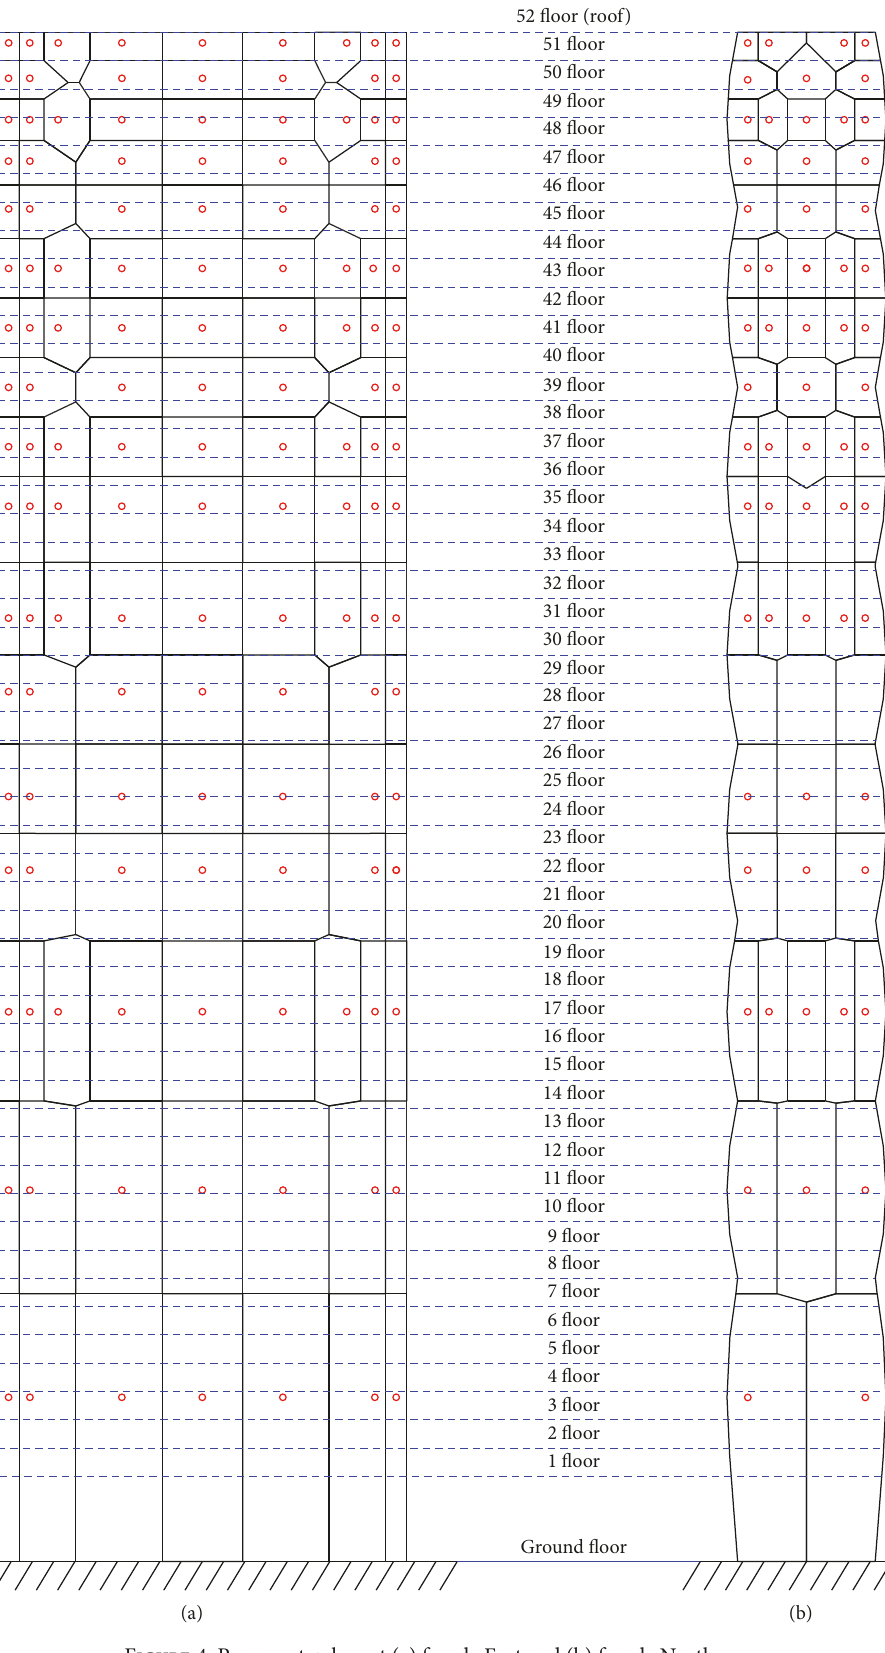
Figure 4: Pressure tap layout (a) facade East and (b) facade